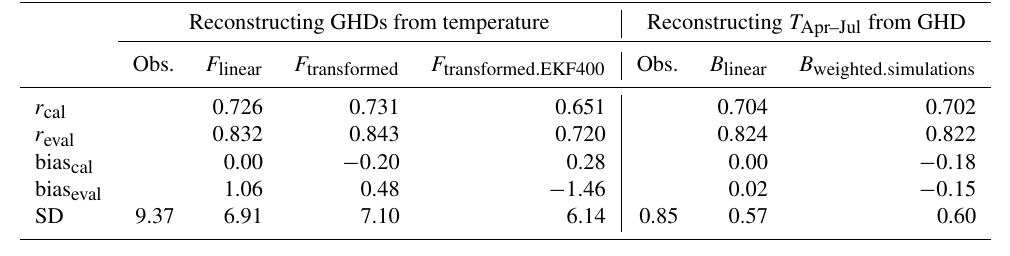
Table 5. Reconstruction statistics for the forward ( F ) and backward ( B ) models. “Obs.” denotes observations. All models were calibrated against observations in the 1659–1850 period ( B weighted . simulations is not calibrated but uses the calibrated model F transformed . CCC400 ) and evaluated in the period 1851–2018. F transformed . EKF400 denotes the application of the calibrated model F transformed to EKF400. “Calib.” and “Eval.” indicate the model statistics in the calibration and evaluation periods, respectively, and SD indicates the standard deviation (in days and degrees Celsius, respectively) for the common period (1659–2004). Numbers for EKF400 refer to the ensemble mean of 30 reconstructions.